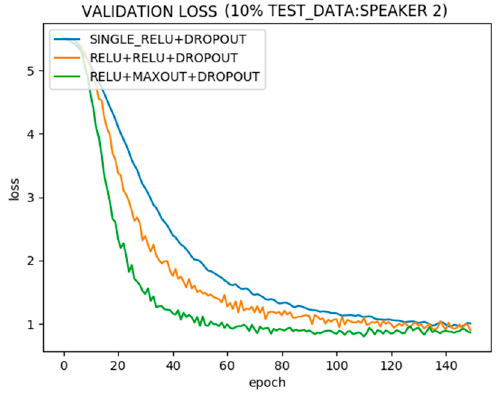
Figure 6. Test error vs. iterations for network architectures.